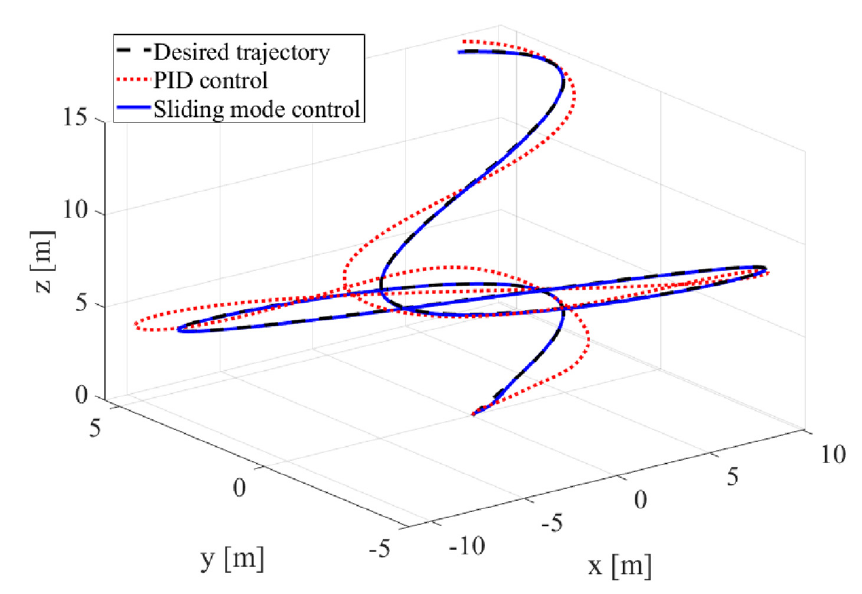
Figure 5. Trajectory tracking performance of the flying-type firefighting system in three-dimensional view.